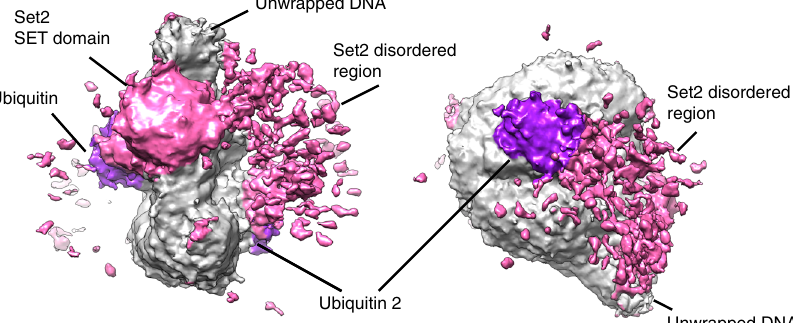
Fig. 5 Set2 auxiliary regions bind the nucleosome. Cryo-EM map resolved to 4.2 Å showing a subset of particles with the noisy density next to the nucleosome. The noisy density is spanning from the Set2 SET domain and the unwrapped DNA to the second ubiquitin on the opposite side of the nucleosome. This density is generated by auxiliary Set2 domains and disordered regions. Ubiquitin is shown in violet, Set2 in pink, and NCP in